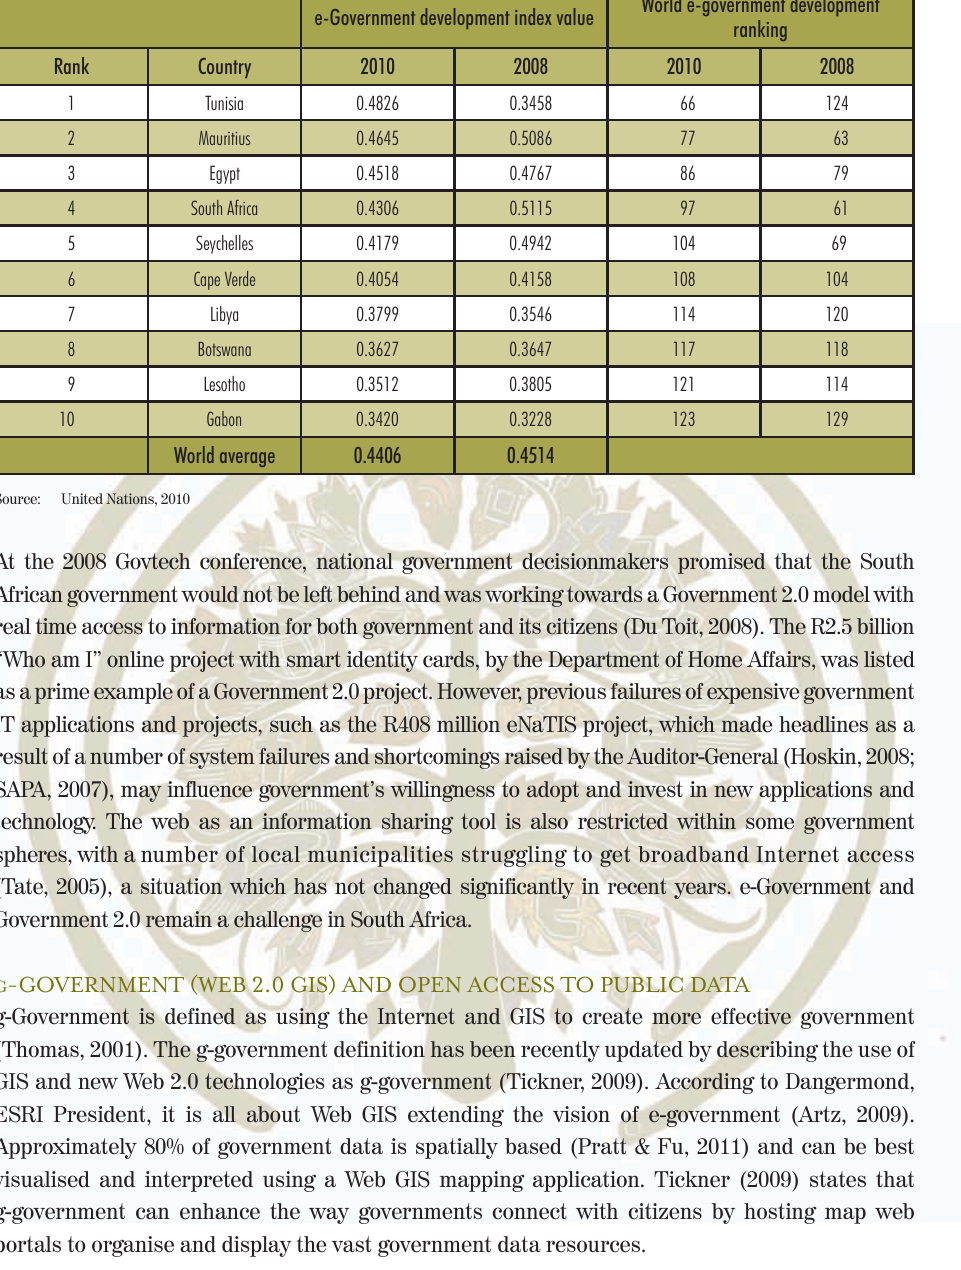
2010 UNITED NATIONS RANKING OF E -DEVELOPMENT IN AFRICA World e-government development e-Government development index value